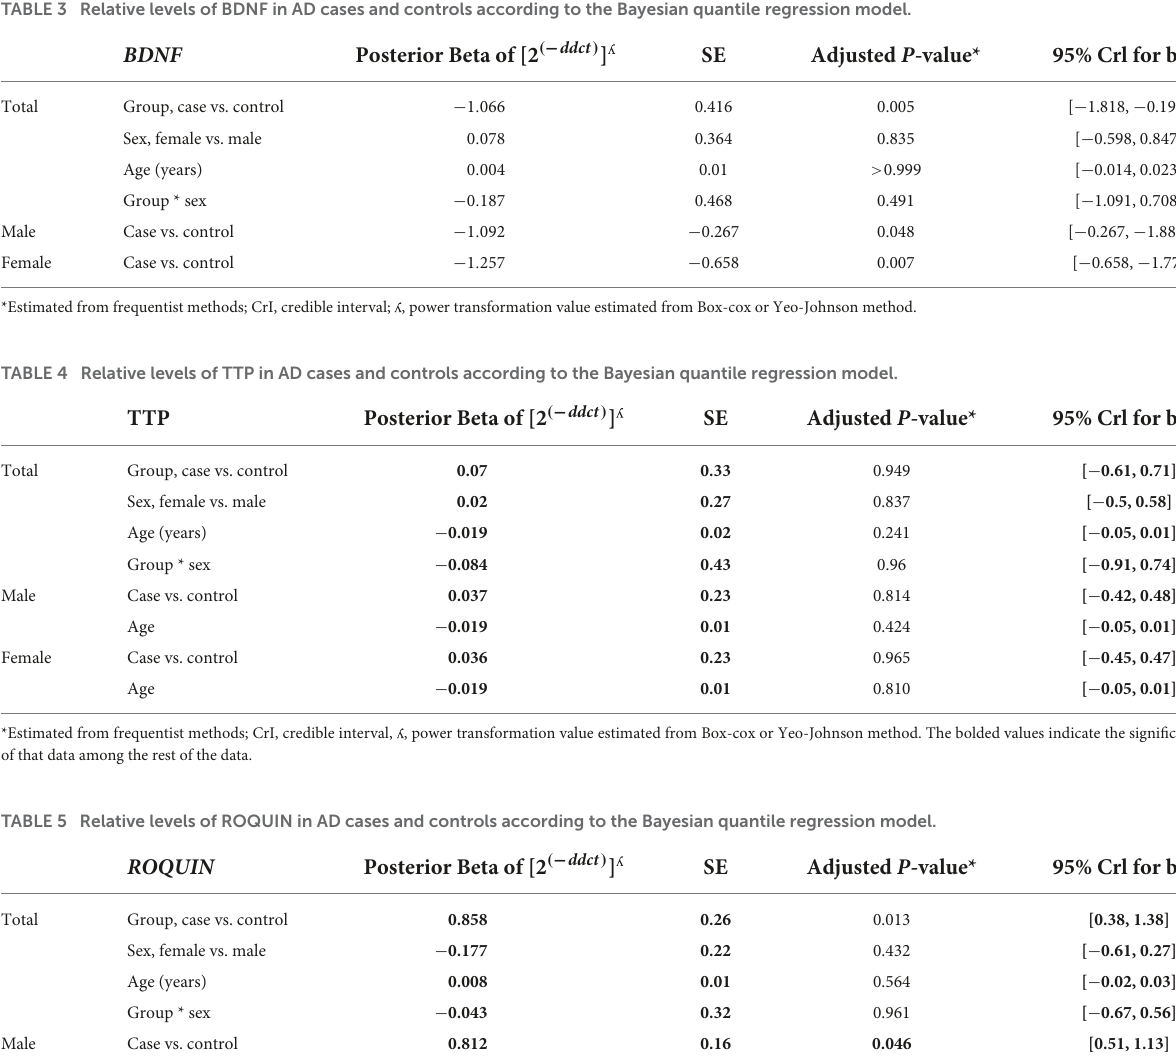
Case vs. control Age Case vs. control 0.811